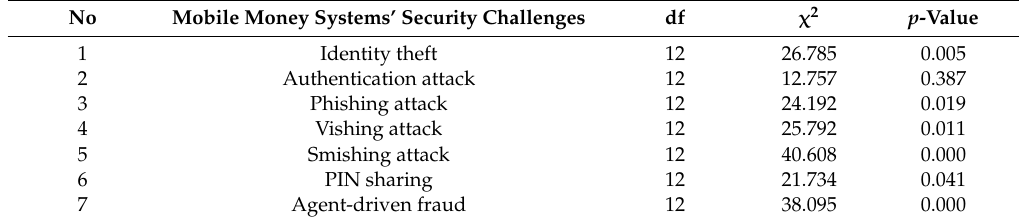
Table 8. Relationship between mobile money usage duration and mobile money systems’ security challenges.